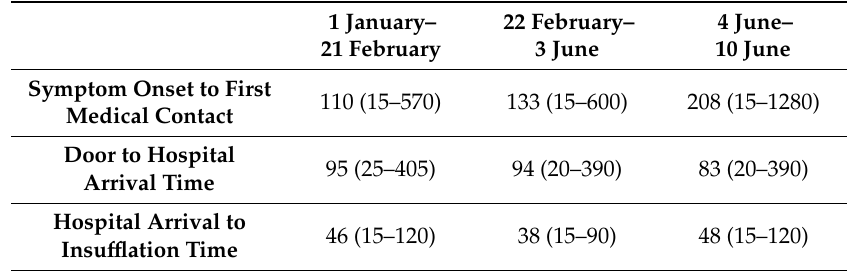
Table 3. Key time points (in minutes) in STEMI care (Ospedale del Cuore-Massa) before and after COVID-19